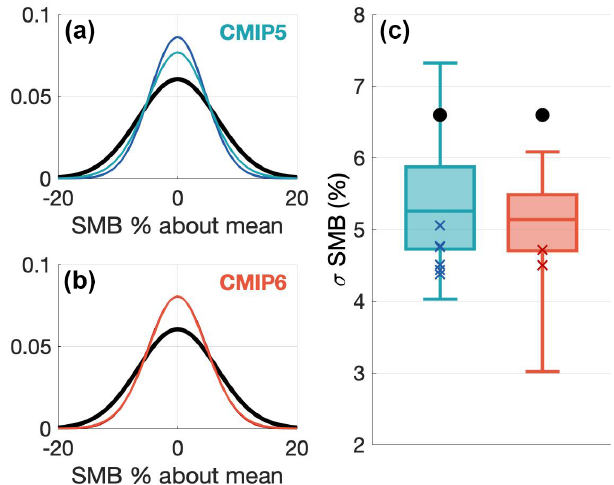
Figure 5. Gaussian distributions of SMB where the standard devi- ation is that of the SMB time series for the reconstruction (black). (a) All CMIP5 models are in light blue and the best scoring CMIP5 models are in dark blue. (b) All CMIP6 models are in light red and all CMIP6 models are in red (the two Gaussians, here, are largely indistinguishable by eye as they overlap almost entirely). (c) Box plots of the CMIP5 (blue) and CMIP6 (red) SMB time series stan- dard deviations. The black dots show the standard deviation of the original MERRA-2 reanalysis.